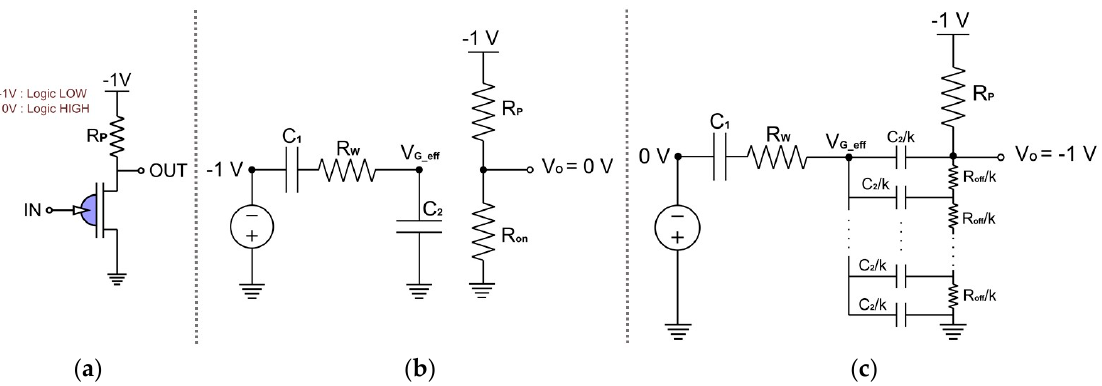
Figure 2. ( a ) Inverter circuit; ( b ) Inverter equivalent circuit when WG-FET is on; ( c ) Inverter equivalent circuit when WG-FET is